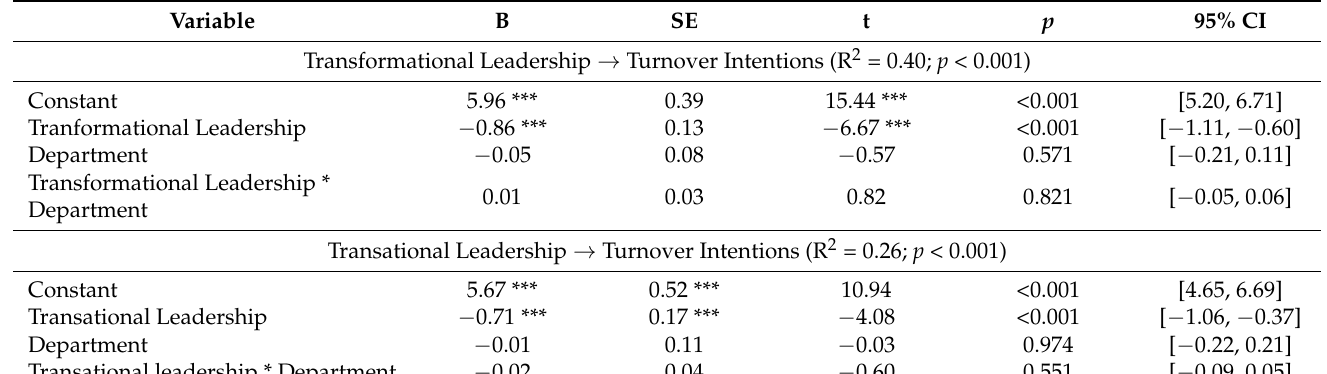
Table 8. Moderating effect of the activity